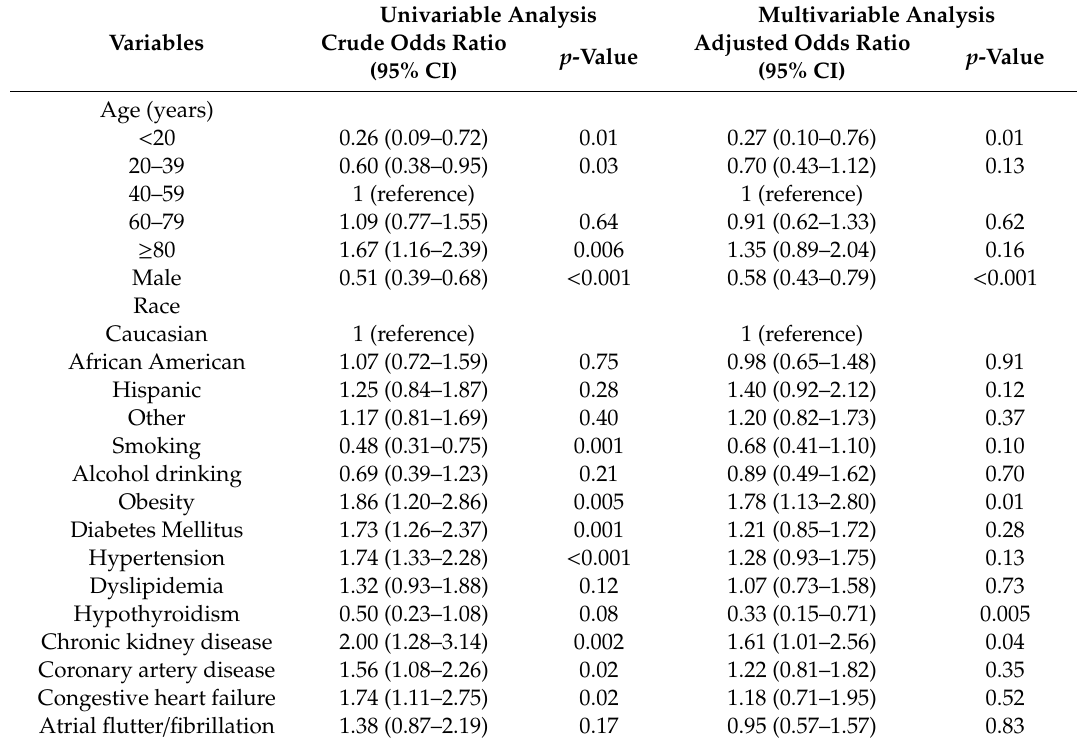
Table 2. Univariable and multivariable analysis assessing factors associated with acute myocardial infarction in heat stroke